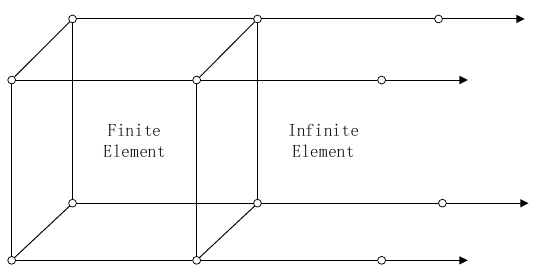
Figure 2. Finite element and infinite element (FE-IE) coupling model.